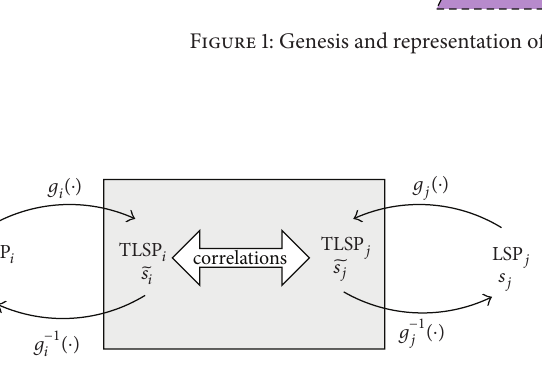
Figure 2: LSP are characterized and synthetized in transformed domain.